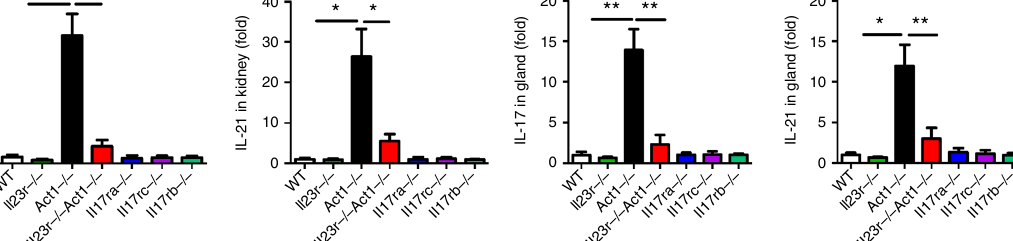
control Act1 − / − mice (Supplementary Fig. 3f – h). Taken together, these results indicate that IL-23R is required for the SLE- and Sjögren ’ s-like diseases associated with Act1 de fi ciency. Impor- tantly, Sjögren ’ s-like and SLE-like diseases were not observed in the Il17ra − / − , Il17rc − / − , and Il17rb − / − mice (Fig. 3a – d). These results indicate that the autoimmune phenotype in Act1 − / − mice is probably independent of the role of Act1 in IL-17 signaling. IL-21R is required for the autoimmunity in Act1 − / − mice . We further investigated the molecular and cellular mechanism for how IL-23R-dependent Th17 response promotes autoimmunity